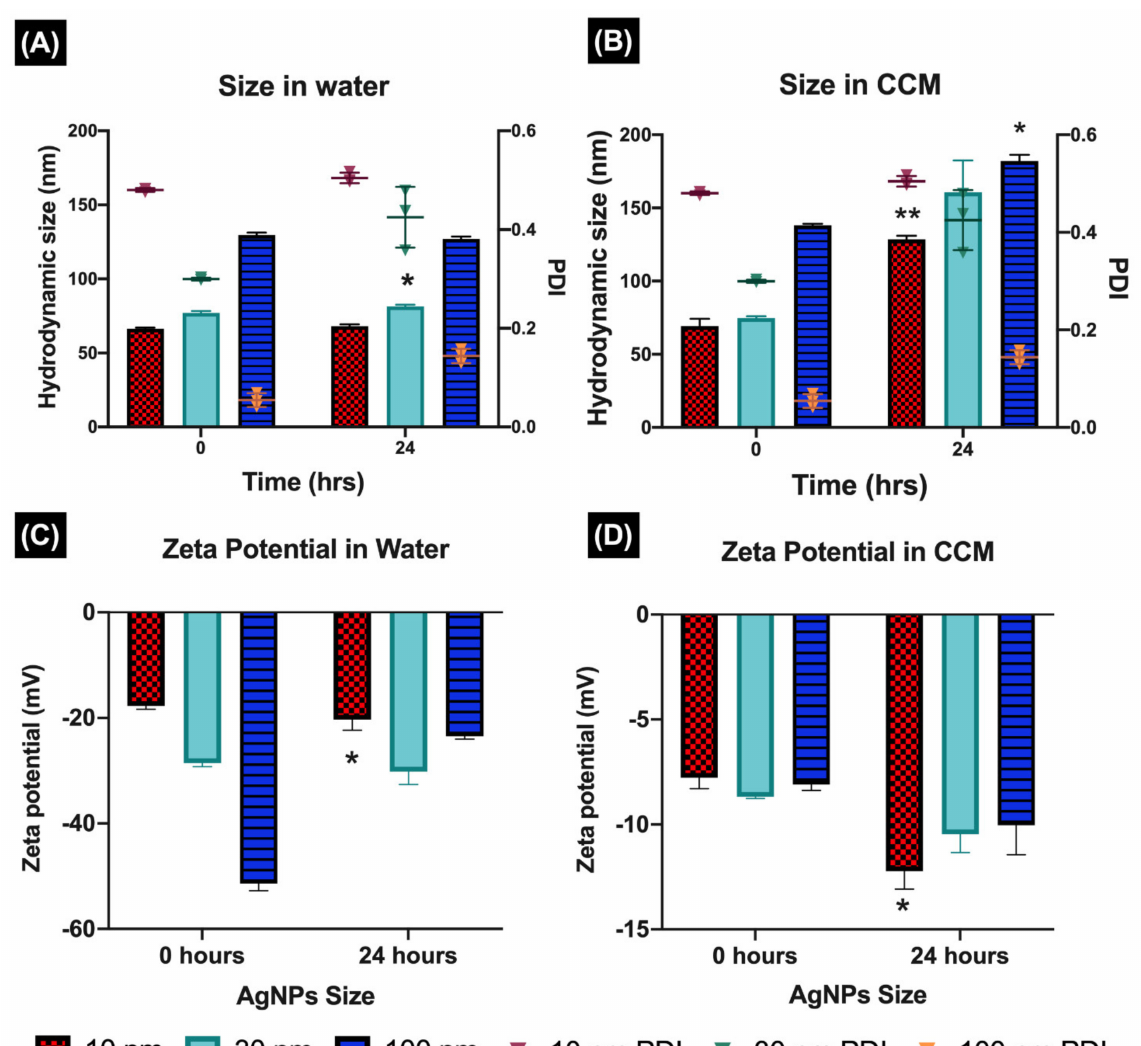
Figure 1. Characterisation of AgNPs. The characterisation of the AgNPs was performed following 0 and 24 h of incubation in water and CCM by DLS. ( A , C ) show the hydrodynamic size and zeta potential in water. ( B , D ) show the hydrodynamic size and zeta potential in CCM. The A and B left axes show the PDI recorded for each AgNPs sample. Data with asterisks * indicate statistical differences (* p < 0.05 and ** p < 0.01) between timepoints (0 and 24 h) for the selected NP